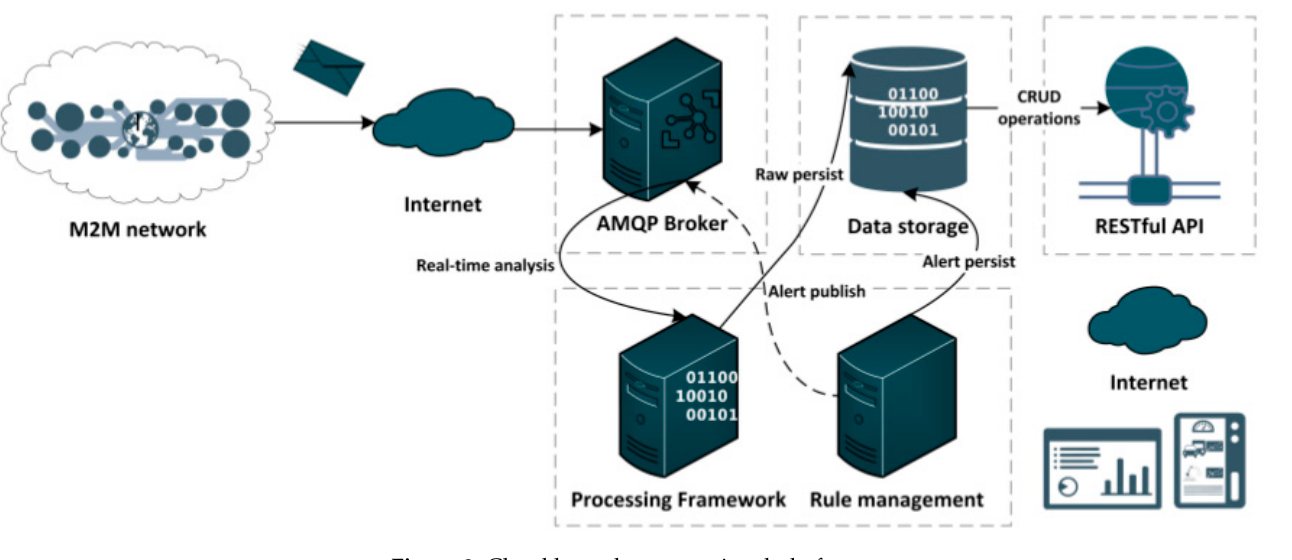
Figure 3. Cloud hosted computational platform .